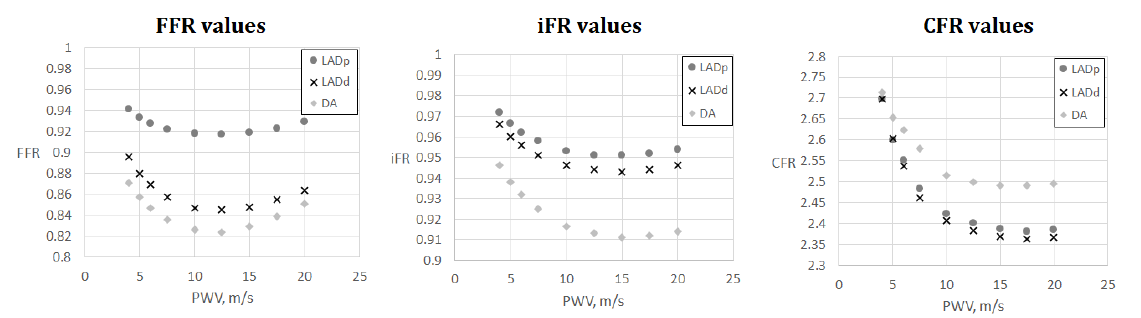
Figure 5. FFR, iFR and CFR sensitivity to AoPWV for patient 6. Patient 6 had three stenoses located in the proximal part of the left anterior descending artery (LADp), distal part of the left anterior descending artery (LADd) and middle part of the diagonal artery